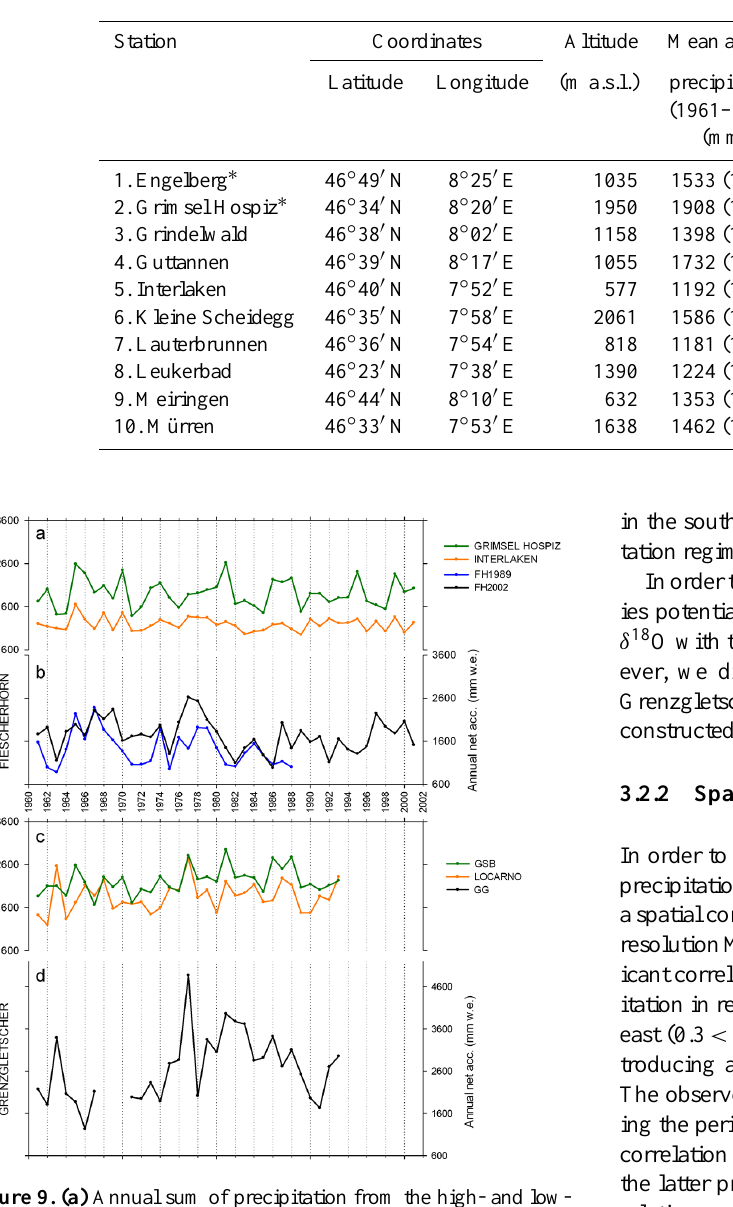
Table 2. Mean annual precipitation over the period 1961–2001 for the stations near the Fiescherhorn glacier, together with their interannual variability, expressed as 1 σ / mean value in percent (in parentheses). Asterisks indicate homogenized data. Pearson correlation coefficient of the precipitation with the annual net accumulation (offset= − 1year) at Fiescherhorn glacier. Values of correlation coefficients statistically significant at the 5% level are in bold.